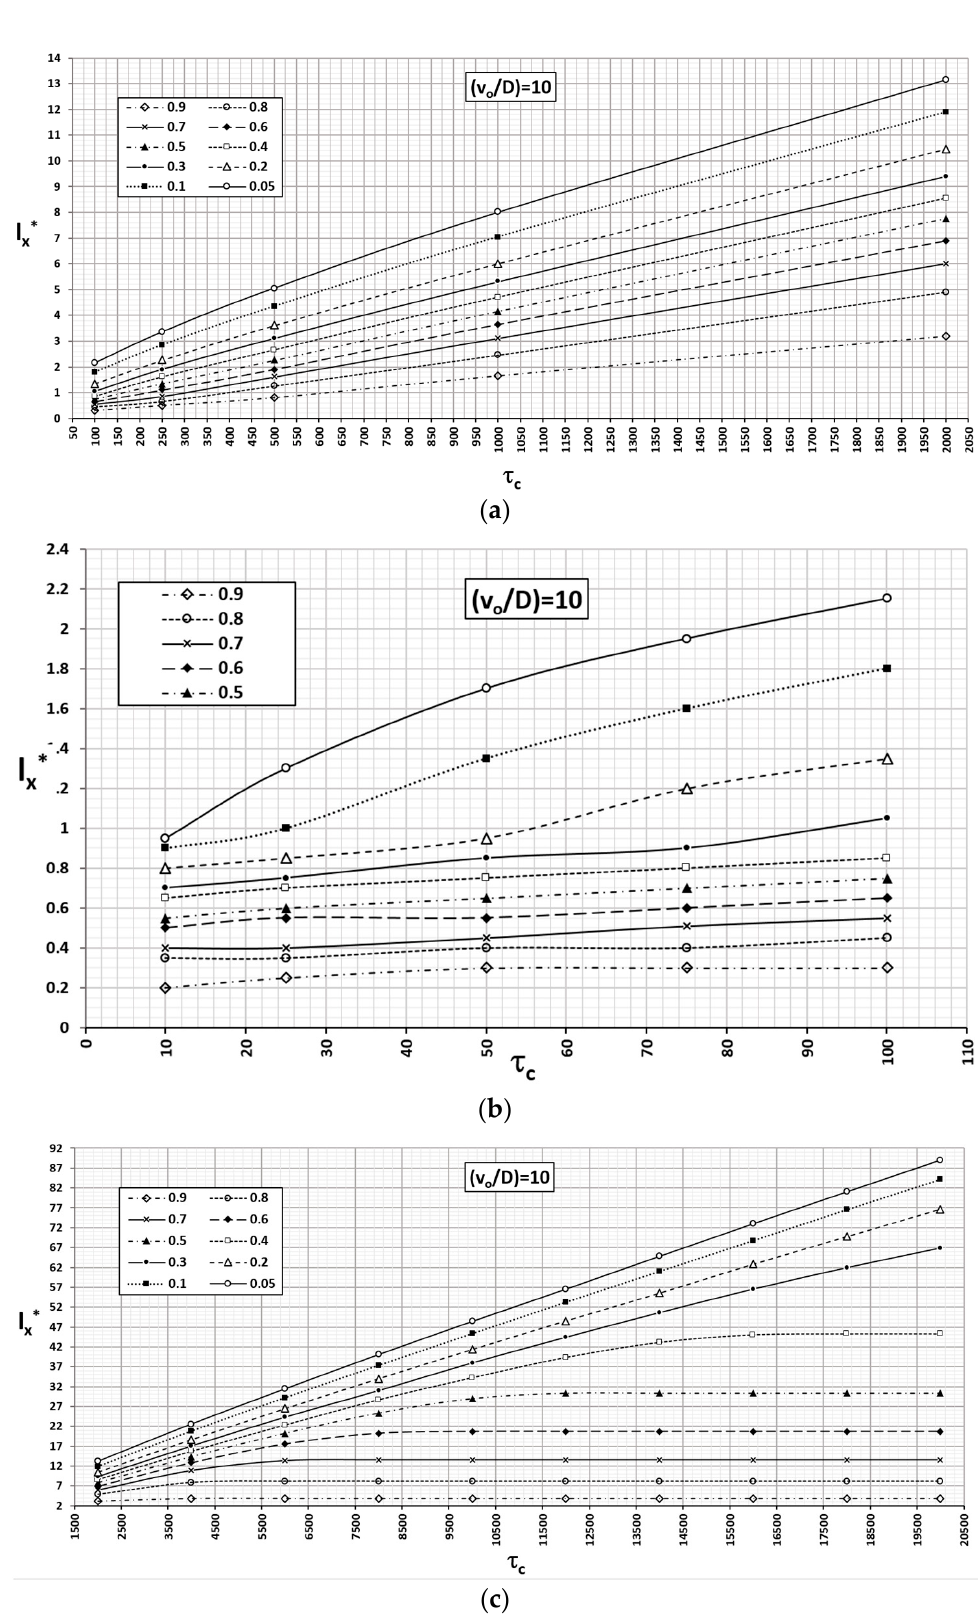
)∗ as a function of time factor τ as a function of time factor τ c . Parameter of the abacus v o (cid:2934)((cid:2913) (cid:4594) x ( c (cid:48) )